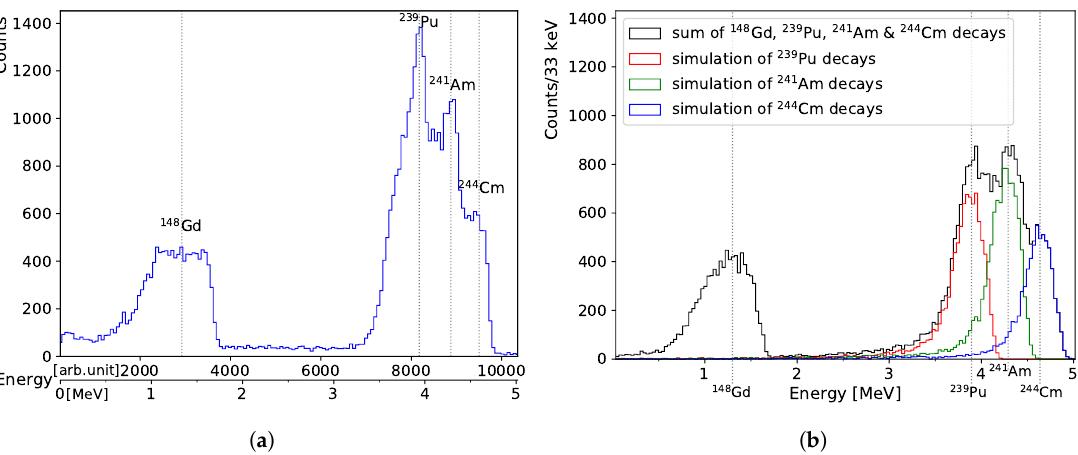
Figure 4. Comparing the measured response of our DIY particle detector to a reference α -source on the left with a simulation using the AASI software [28] on the right. The lower axis in ( a ) shows the energy scale after applying the calibration from Figure 5. The simulation parameters applied in ( b ) take into account the estimated ambient air density during the measurement (1.123kg/m 3 ) and corresponding geometries of the source (19mm diameter), the diode and their positions (distance of